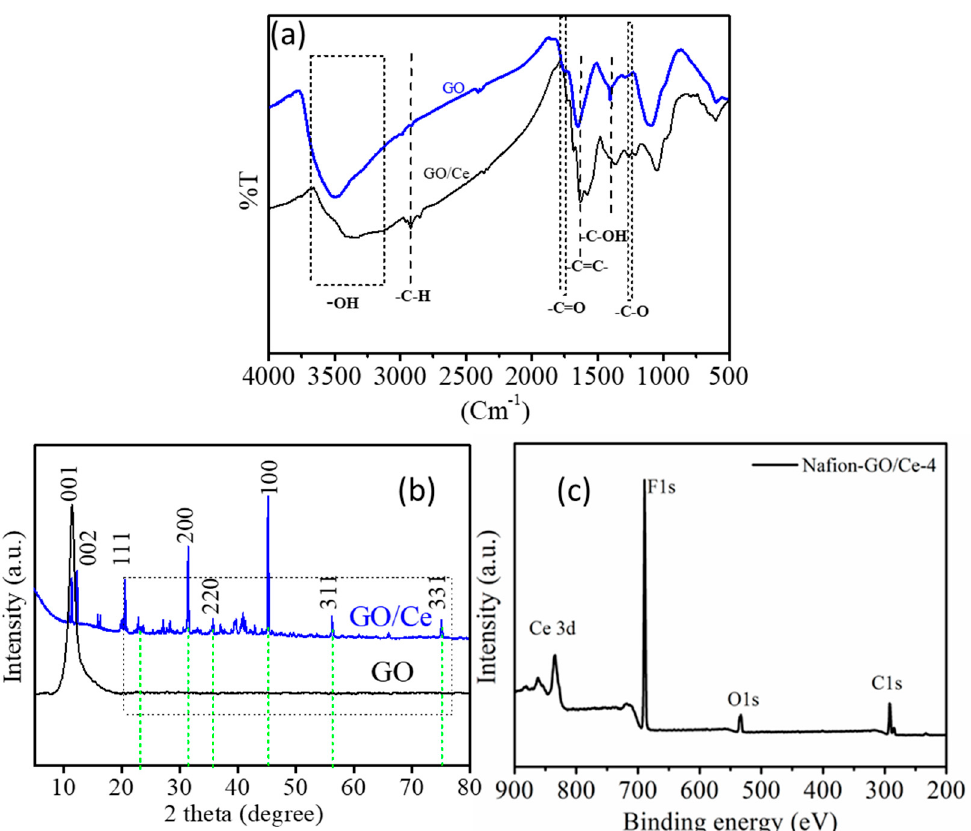
Figure 1. ( a ) FT − IR of GO and GO/Ce, ( b ) XRD spectra of GO and GO/Ce hybrid material, ( c ) XPS spectra of composite membrane.